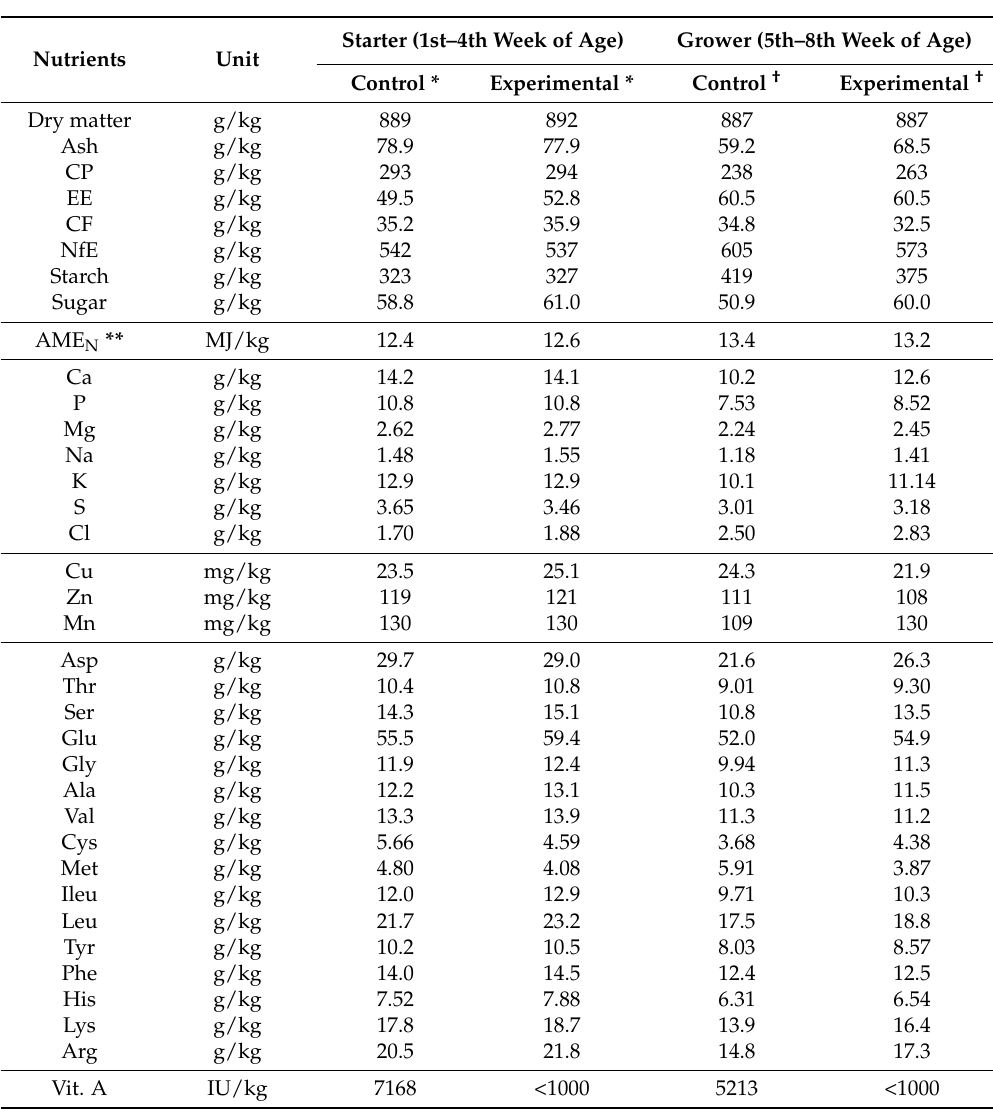
Table 1. Analysed nutrient contents of the diets during the whole trial on dry matter